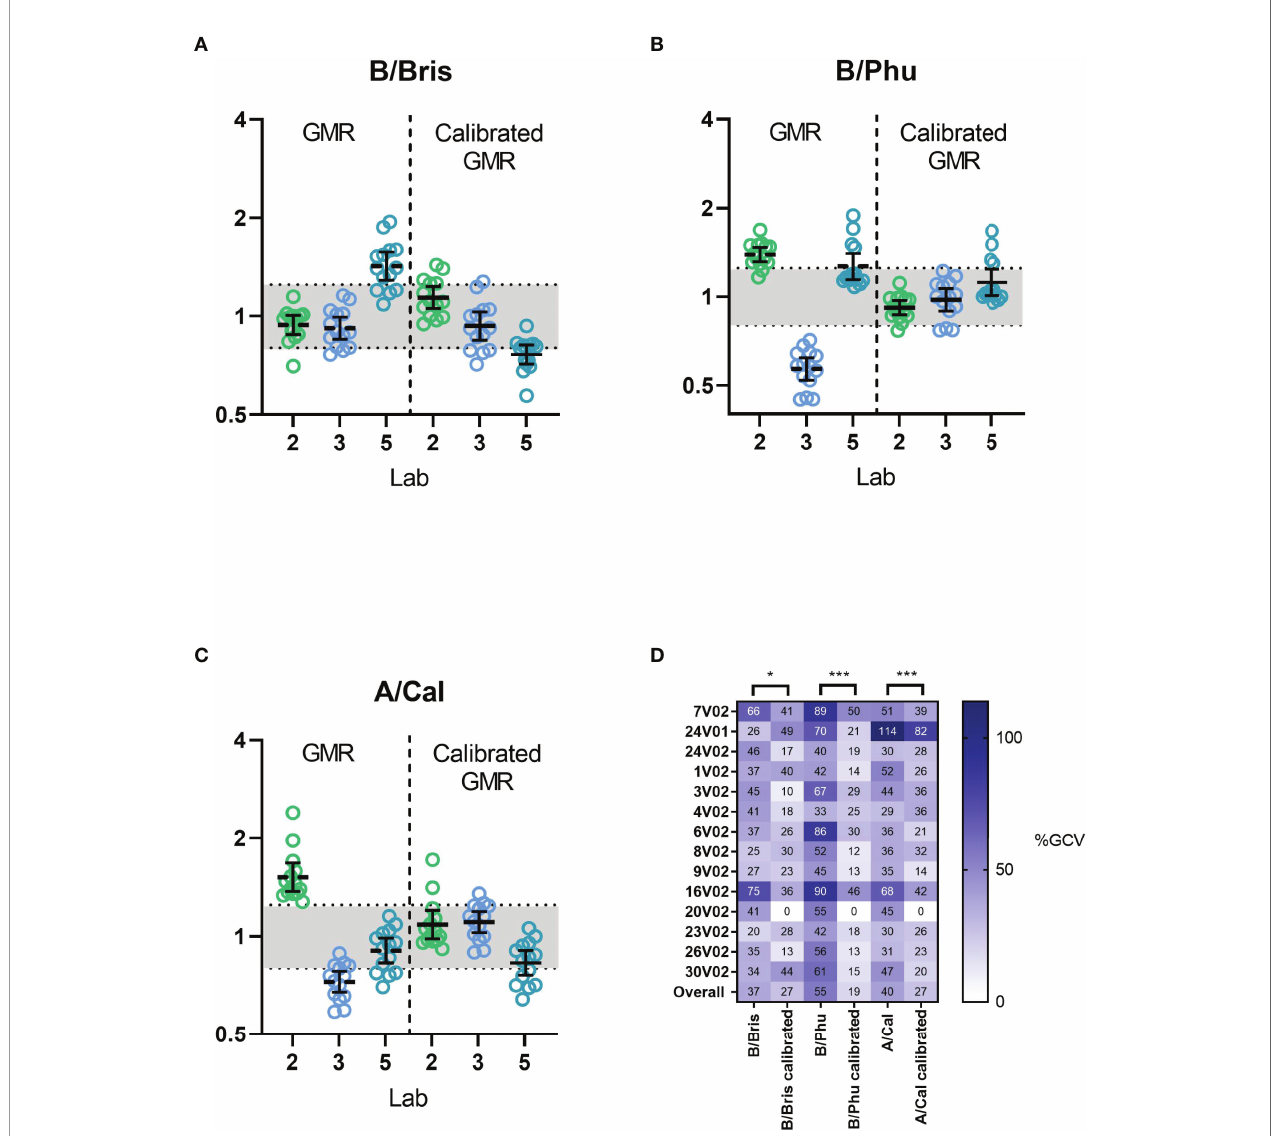
FIGURE 6 | Inter-laboratory performance before and after calibration. Three reverse genetics (RG) in fl uenza viruses, (A) H9 with B/Brisbane/60/2008 NA, (B) H9 with B/Phuket/3073/2013 NA and (C) H7N1 with A/California/07/2009 NA, were tested using the FLUCOP ELLA-NI SOP. Geometric mean ratios (GMR) of ELLA-NI titres are shown before (left) and after (right) calibration using serum sample 20 V02 as a calibrator. The indicative range of [0.8-1.25] is shaded in light grey. The geometric mean and 95% CI error bars are plotted in black. (D) %GCV per sample is shown before and after calibration (negative samples 7V01 and Ig- were excluded from analysis). * indicates statistical signi fi cance using the Wilcoxon matched pairs test [* P=0.0494, ***P=0.0001 and ***P=0.0009